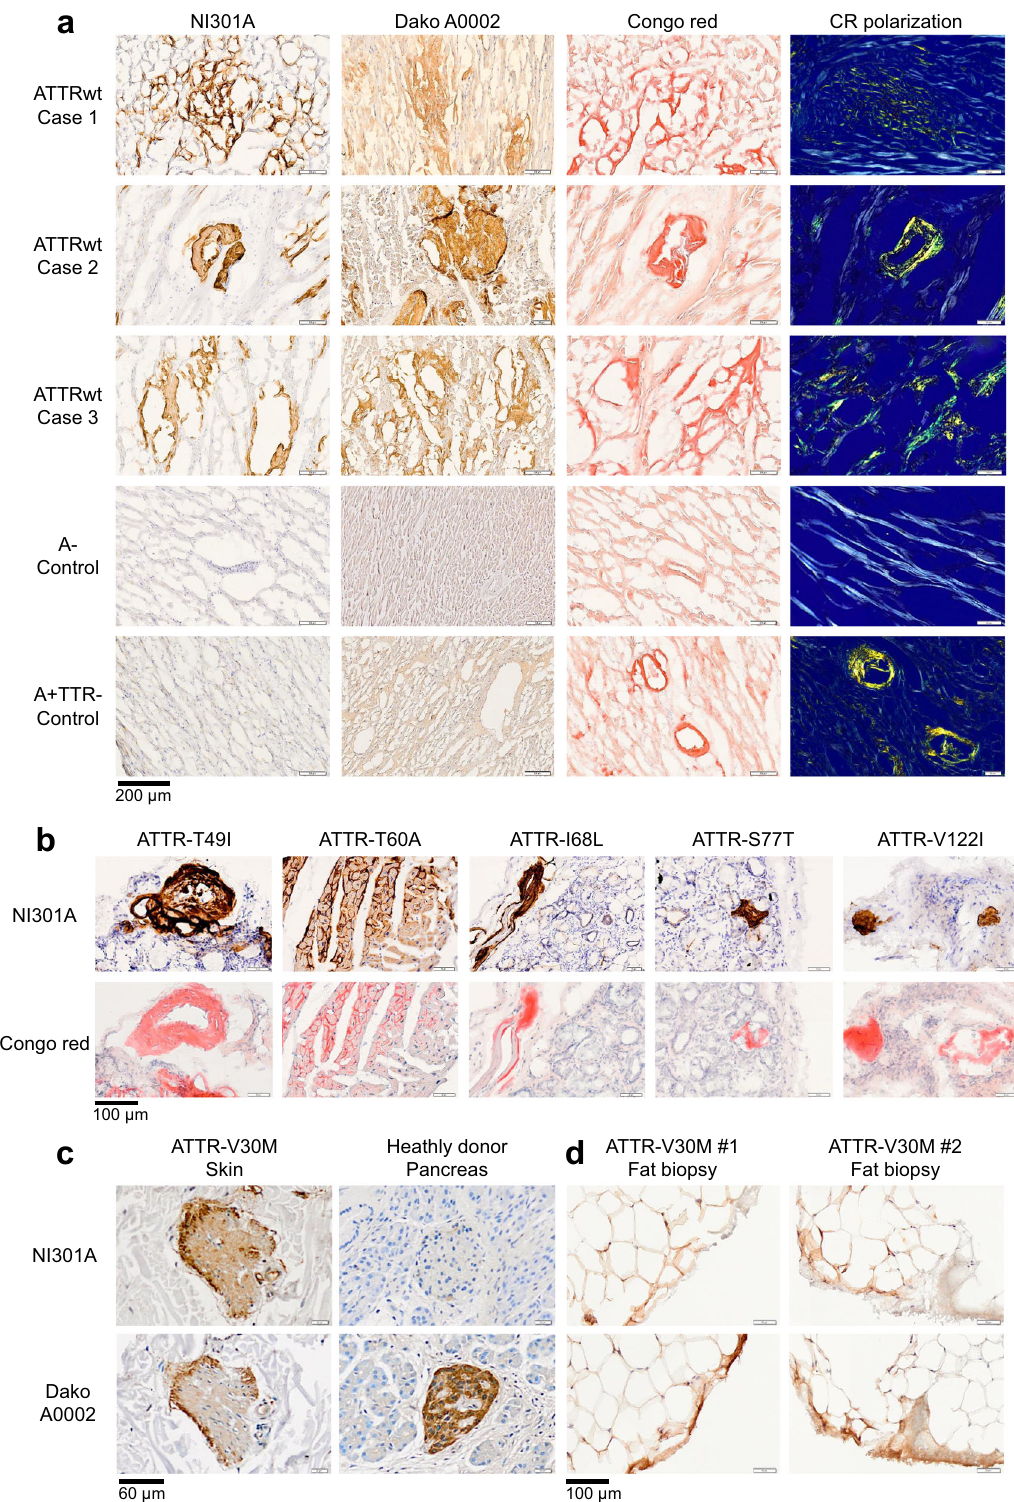
Fig. 2 NI301A binds TTR amyloid present in sporadic and hereditary cases of ATTR amyloidosis with cardiomyopathy and polyneuropathy. a IHC using NI301A on frozen post-mortem heart tissues collected from three sporadic cases with ATTRwt cardiomyopathy, a case without amyloid (A − ), and one with non-TTR amyloid deposits (A + TTR − ). ATTR deposits were identi fi ed by Congo red staining with birefringence and immunostaining with the pan- TTR antibody Dako A0002. b IHC using NI301A and Congo red staining on frozen salivary gland biopsies collected from ATTRv cardiomyopathy patients carrying the variants TTR-T49I, T60A, I68L, S77T, and V122I. c IHC using NI301A and Dako A0002 on skin biopsy from a patient with ATTR-V30M polyneuropathy and on human pancreas tissue. d IHC using NI301A and Dako A0002 on abdominal fat aspirates from two patients with ATTR-V30M